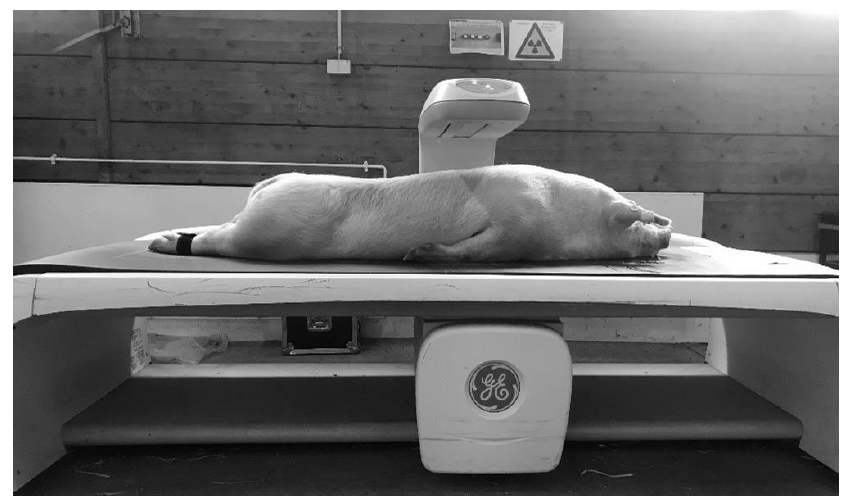
Figure 2. DXA examination.